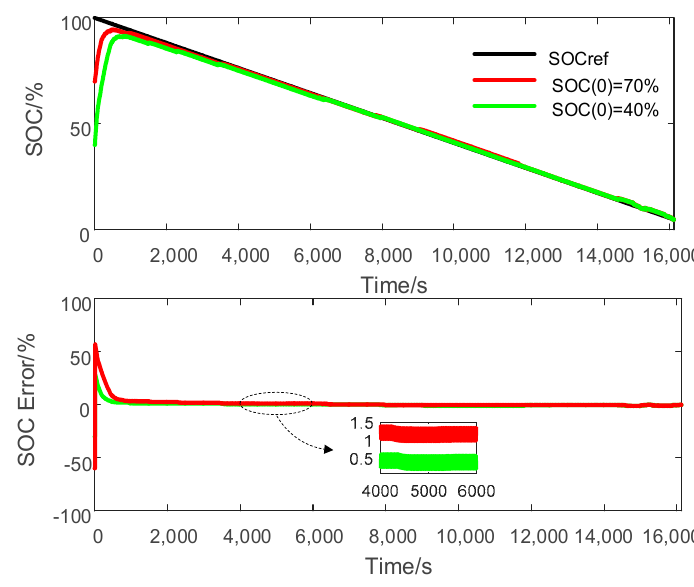
Figure 12. CSMO-based SOC estimation at different initial SOCs with large switching gain.